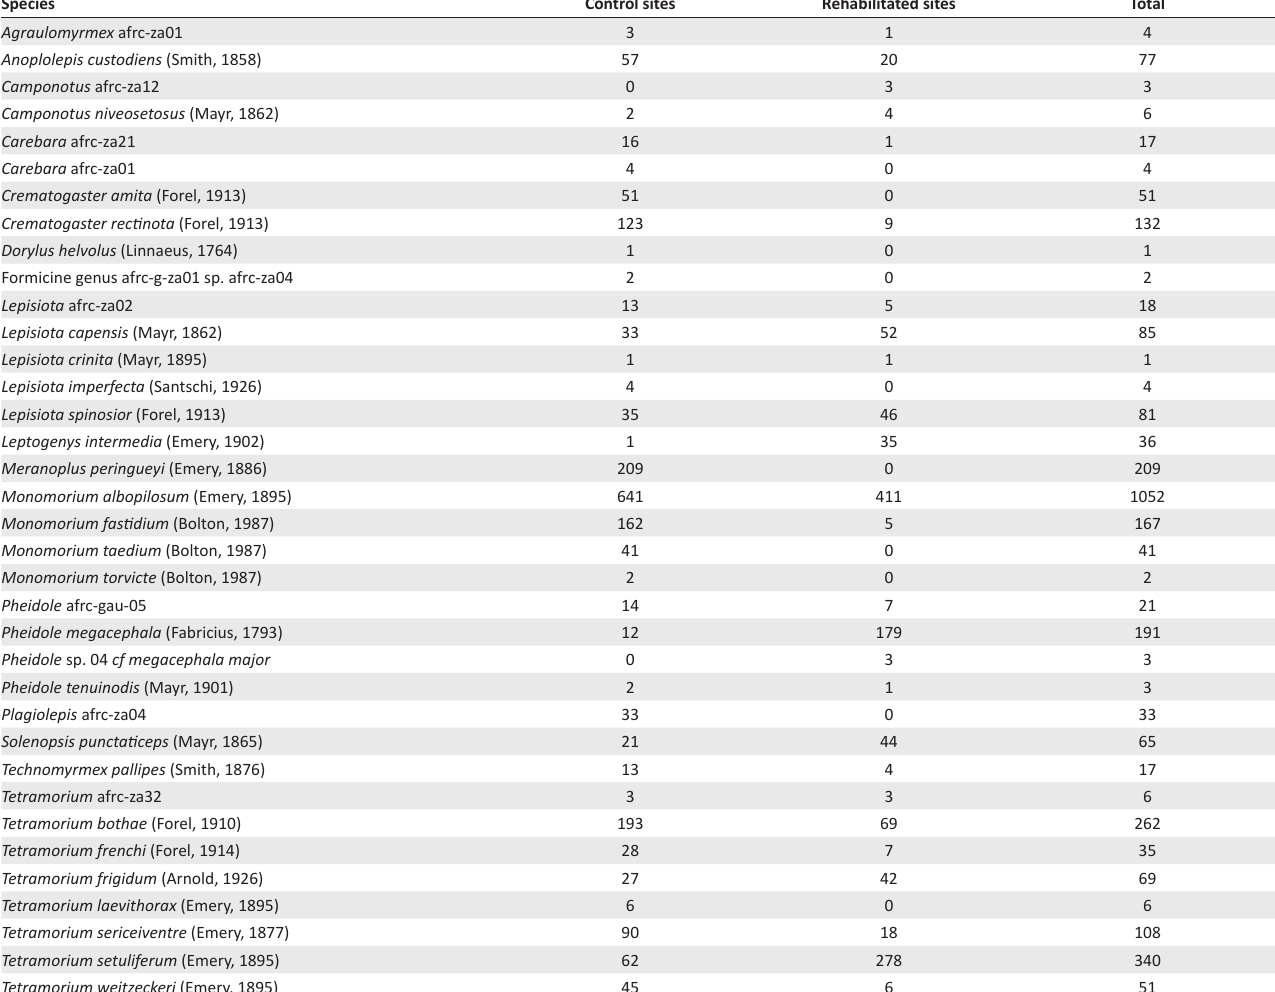
TABLE 1-A3: The number of individuals per species, listed per subfamily, which were collected in total for rehabilitated and control sites on the Rietvlei Nature Reserve, South Africa. Species Control sites Rehabilitated sites Total Agraulomyrmex